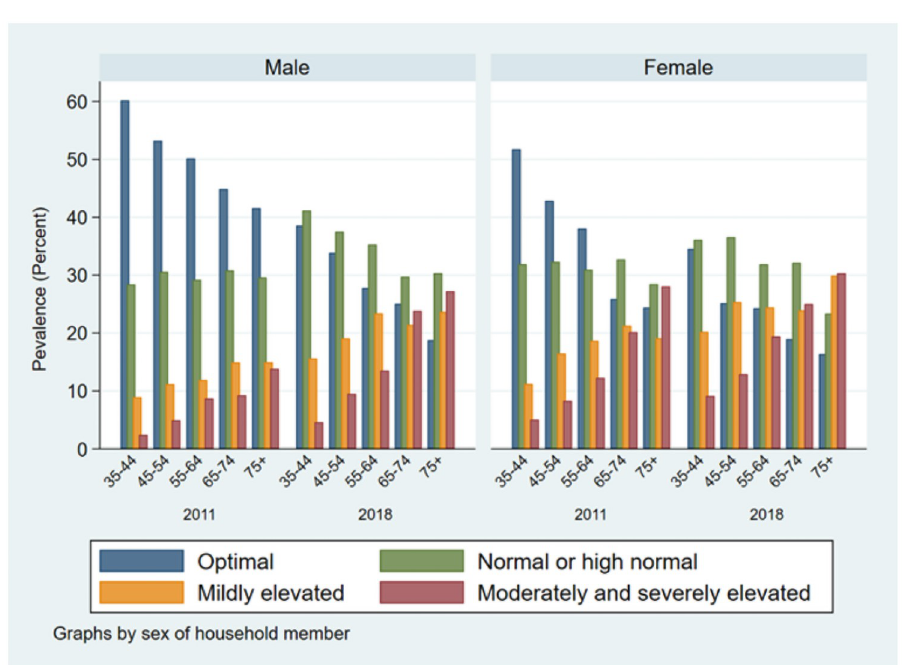
Fig 1. Blood pressure categories by age, sex, and survey year.